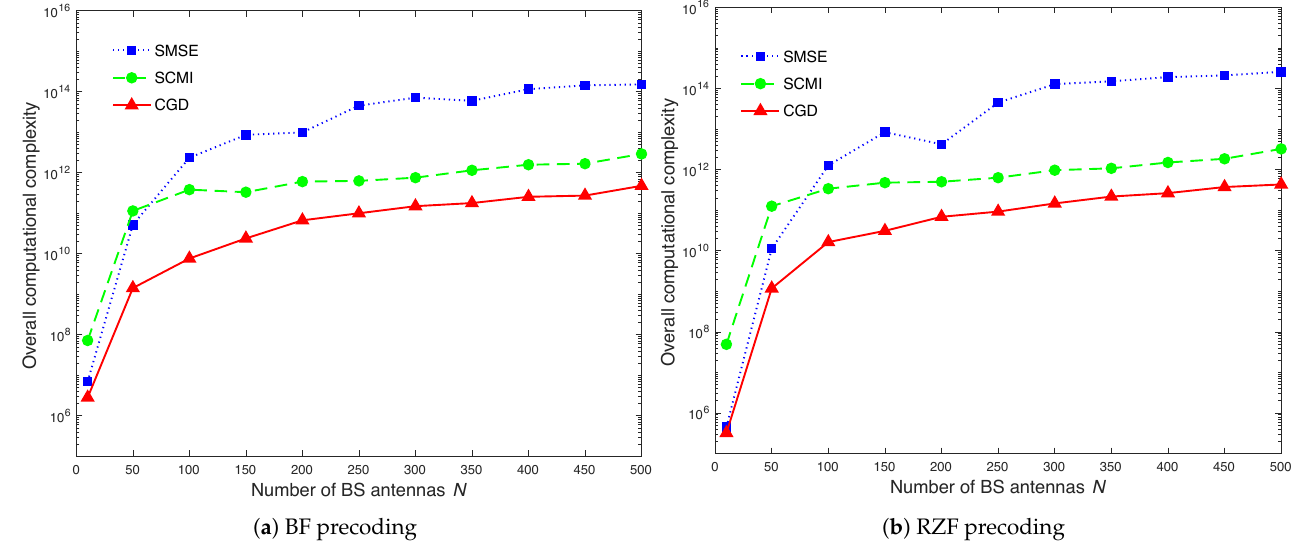
Figure 5. Overall computational complexity versus the number of BS antennas N comparing different training sequence methods corresponding to the pilot length in BF and RZF precoding in the OR model with ω = 25 ◦ , D = 1, T = 100 symbols, ρ d = 10 dB and K = 10